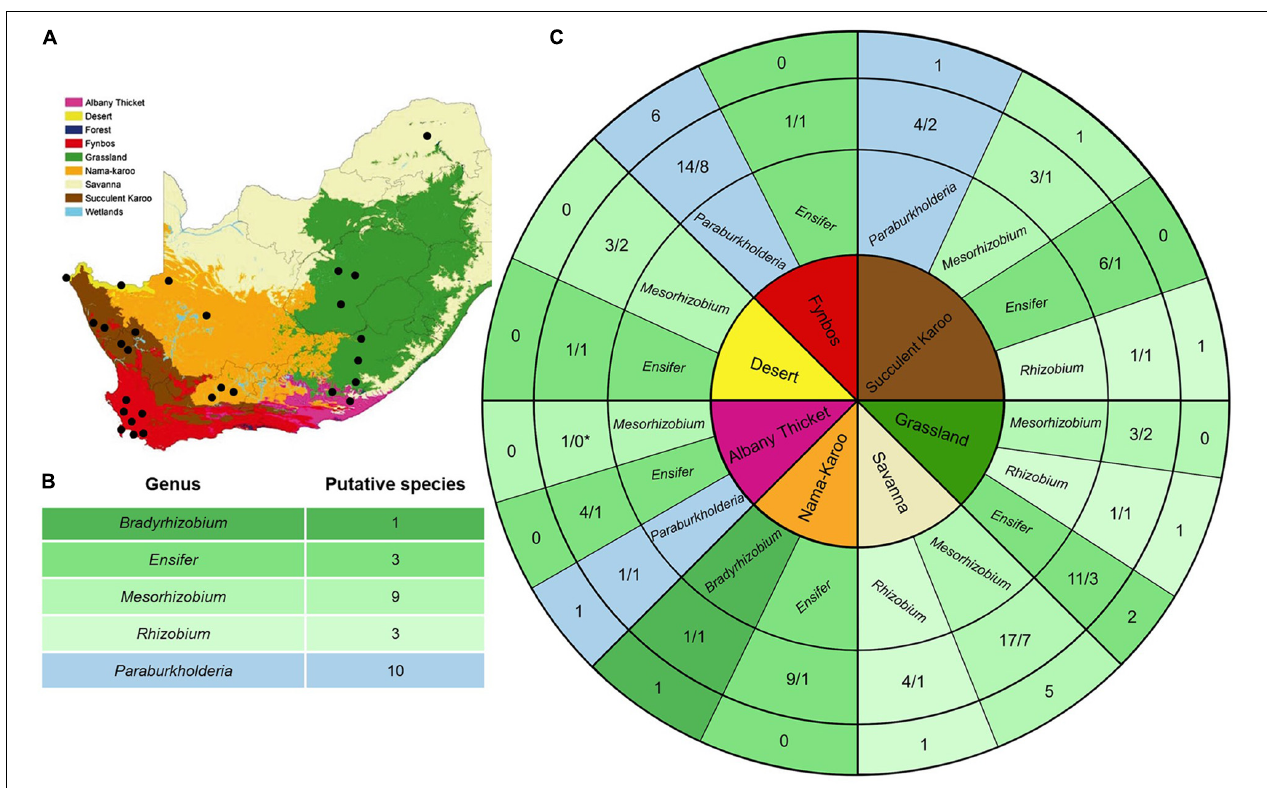
FIGURE 1 | (A) Biome map of South Africa, Lesotho and Swaziland (as in Driver et al., 2005; from the national Spatial Biodiversity Assessment of 2004, courtesy of SANBI). The nine biomes are coloured according to the key and black dots indicate the sampling localities. (B) Summary of the putative species encountered in this study. (C) The core of this diagram lists the seven sampled biomes (colour-coded as in A ). The second track indicates the genera isolated from each biome (with alpha-rhizobia appearing in shades of green while beta-rhizobia appear in blue), while the third track shows the number of isolates sampled from each genus for that specific biome relative to the number of recA phylogeny-based putative species they formed part of. The outer track shows the number of unique recA phylogeny- based putative species recovered for a specific biome for each rhizobial genus. We were unable to amplify the recA gene sequence for the Mesorhizobium isolate recovered from the Albany Thicket which is why it is indicated with an asterisk, as it could not be assigned to a